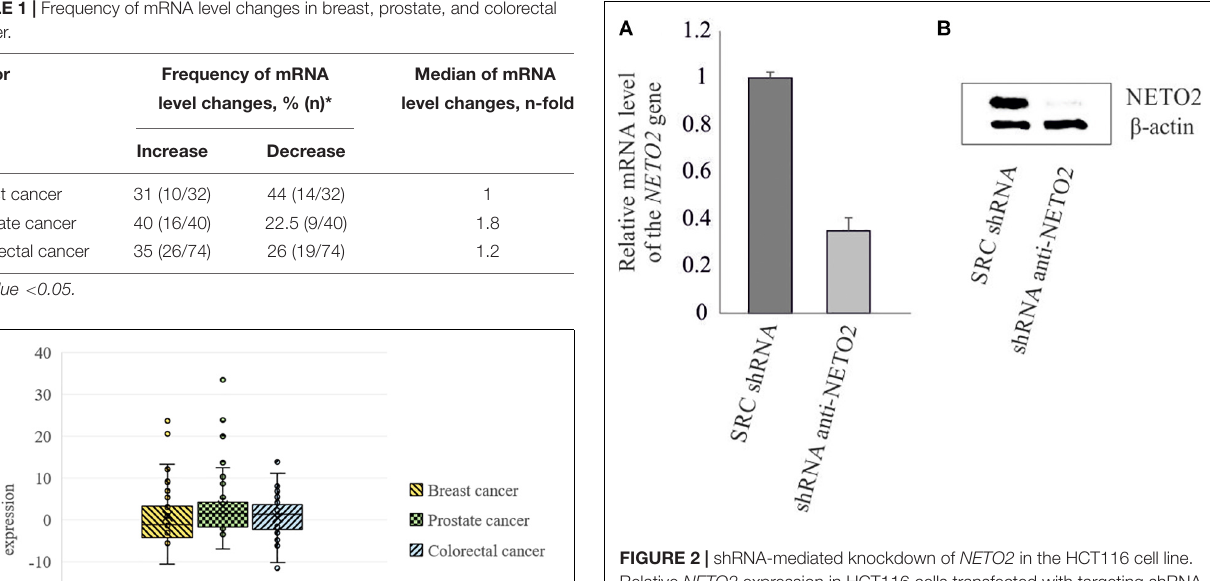
downregulation of nine genes ( MUC16 , KRT6A , ACVRL1 , PTP4A1 , HYAL1 , CLIC3 , TEX19 , DES , and KCNK3 ) and one lncRNAs (AL355075.4) ( Figure 3A